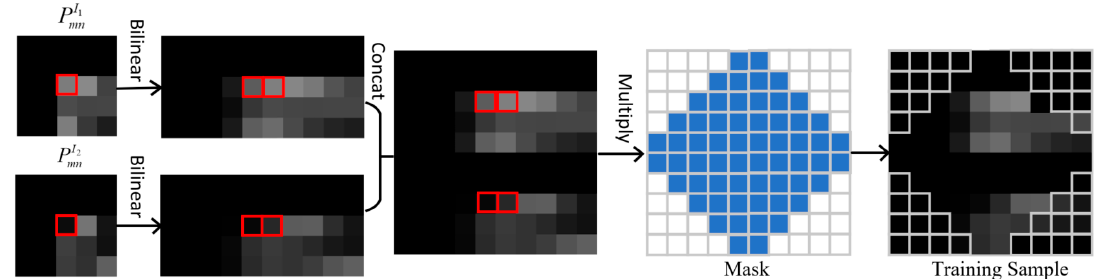
Figure 2. Flowchart of the proposed training sample